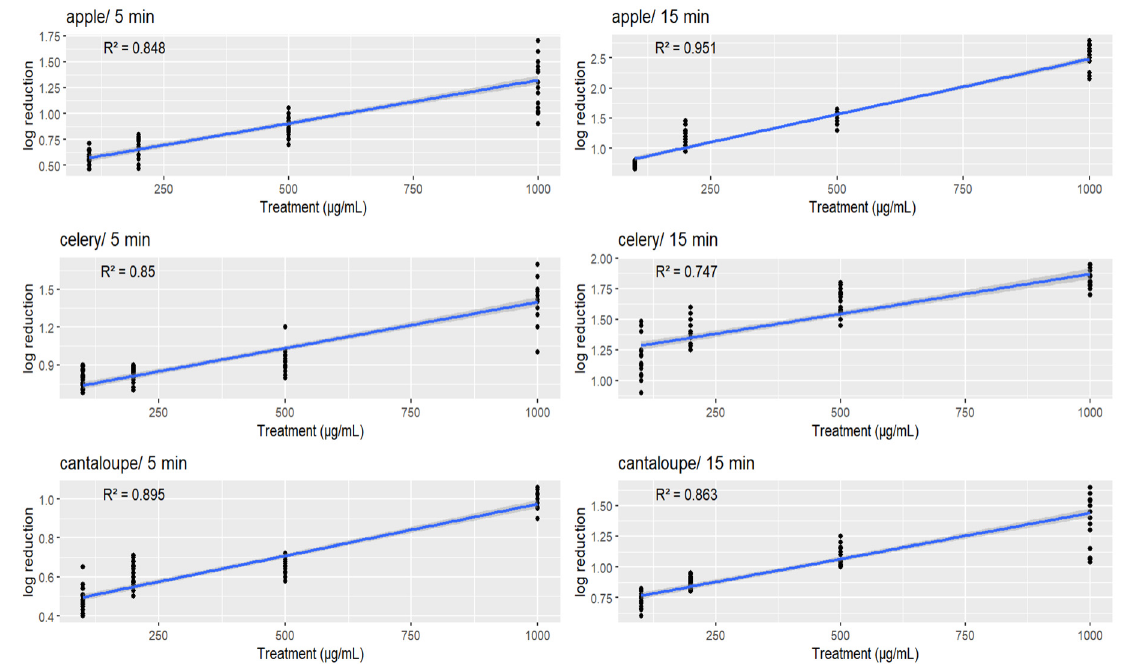
Figure 3. Scatter plots of log reduction in bacteria count on three different produce samples (apple, celery, and cantaloupe) after exposure to di ff erent levels of a treatment (in µg/mL) for either 5 or 15 min. Each data point represents a single experiment, and the blue line represents the linear regres- sion model fi t to the data. The R-squared value is shown on each plot, which indicates the proportion of the variability in the log reduction that is explained by the treatment level.